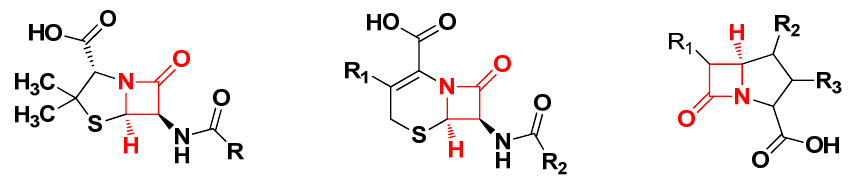
Figure 1. Penicillins, cephalosporins and carbapenems.